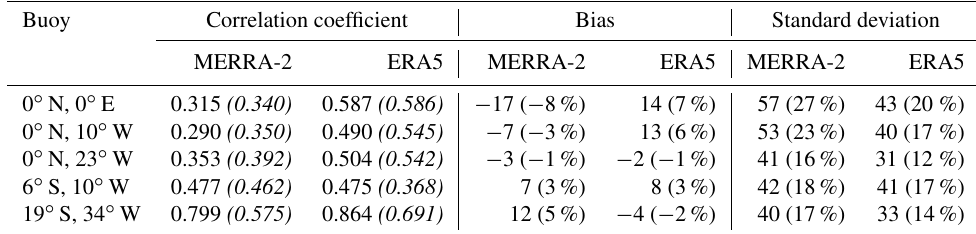
Table 6. Details for each PIRATA buoy and each re-analysis data set: correlation coefficient between measurements and estimates from re-analysis for irradiance and clearness index (in italics), bias and standard deviation (Wm − 2 ) between measurements and estimates for irradiance with relative values (in brackets) for daily means in the period 2012–2013. Buoy Correlation coefficient Bias Standard deviation MERRA-2 ERA5 MERRA-2 ERA5